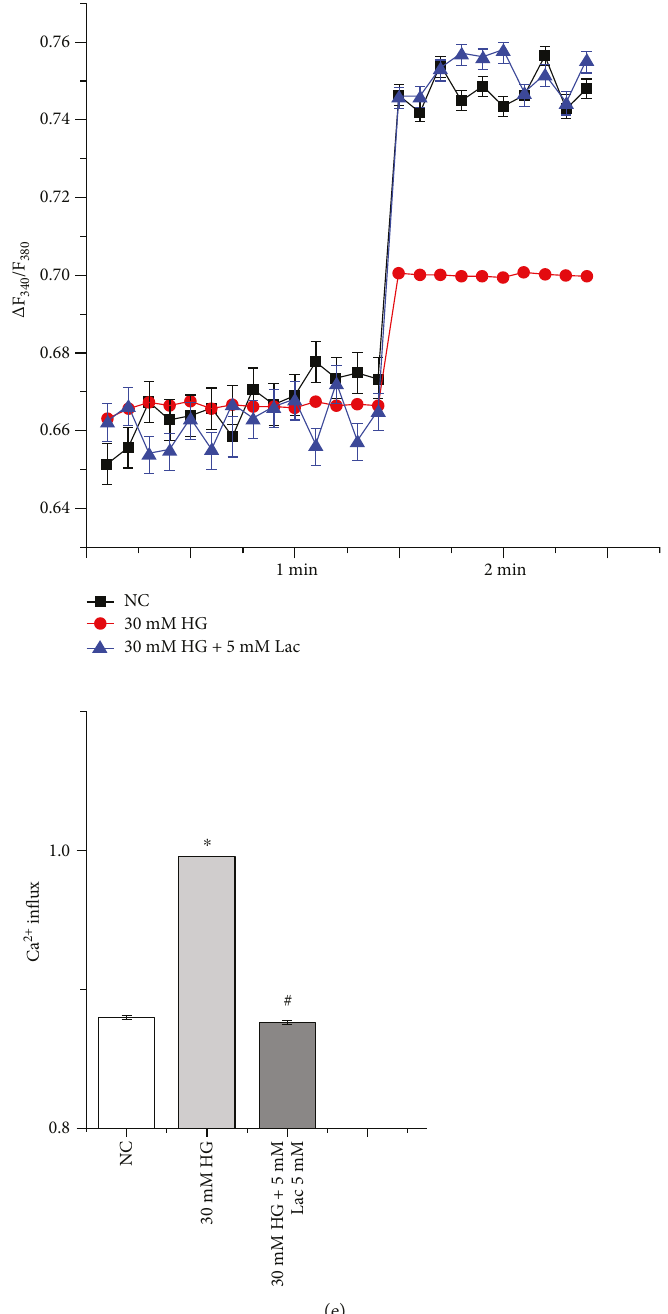
Figure 4: High glucose-induced downregulation of STRs and associated signaling components was reversed by lactisole. Mouse GMCs (SV-40 MES 13) was fi rstly incubated with 3, 5, and 10mM lactisole; then 30mM high glucose (HG) alone was intervened by the indicated concentrations of lactisole following 30mM high glucose for 24 h. (a) Cell viability was determined by MTT analysis. (b) The protein and mRNA expression of T1R2 and T1R3 in GMCs were detected by Western blotting and qRT-PCR. (c) The protein expression of T1R2 and T1R3 in human proximal tubular cells (HK-2) was detected by Western blot. (d) STR-associated signaling components ( α -gustducin, PLC β 2, and TRPM5) were detected by qRT-PCR. (e) GMCs were stimulated with 30mmol/L glucose in the presence (blue), and absence (red) of 5mmol/L lactisole, and the Ca 2+ in fl ux changes in Ca 2+ dye fl uorescence was monitored. Data are expressed as mean ± SD. ∗ p < 0 05 versus NC group. # p < 0 05 versus 30mM glucose (HG) stimulation